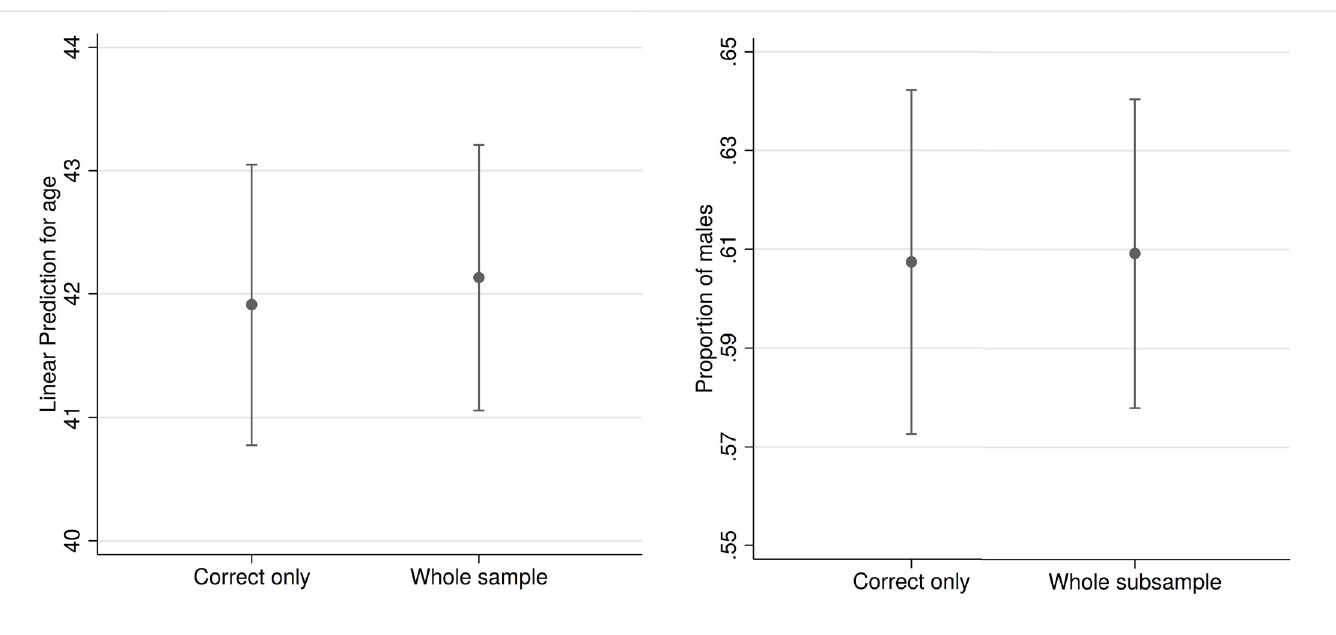
Fig 4. Average age (left panel) and gender proportions (right panel) of correct and the whole subsample and correct-only guess (over-13 detected users only, n = 934 and n = 754).